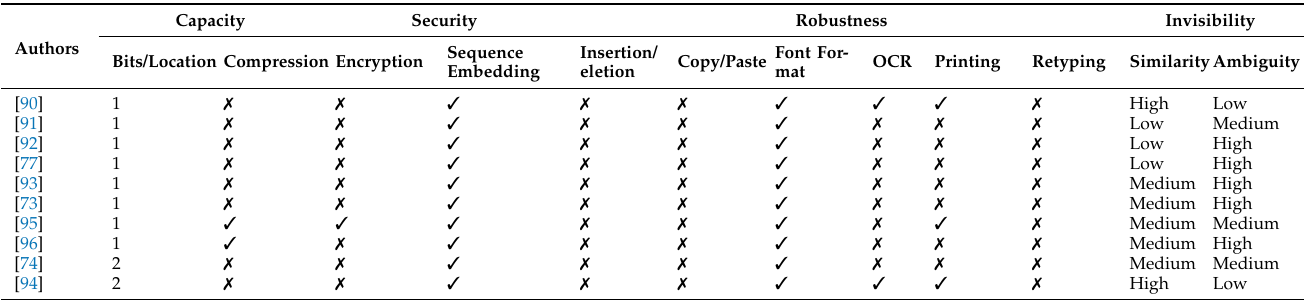
Table 22. Evaluation of kashida method based on invisibility and robustness and capacity.